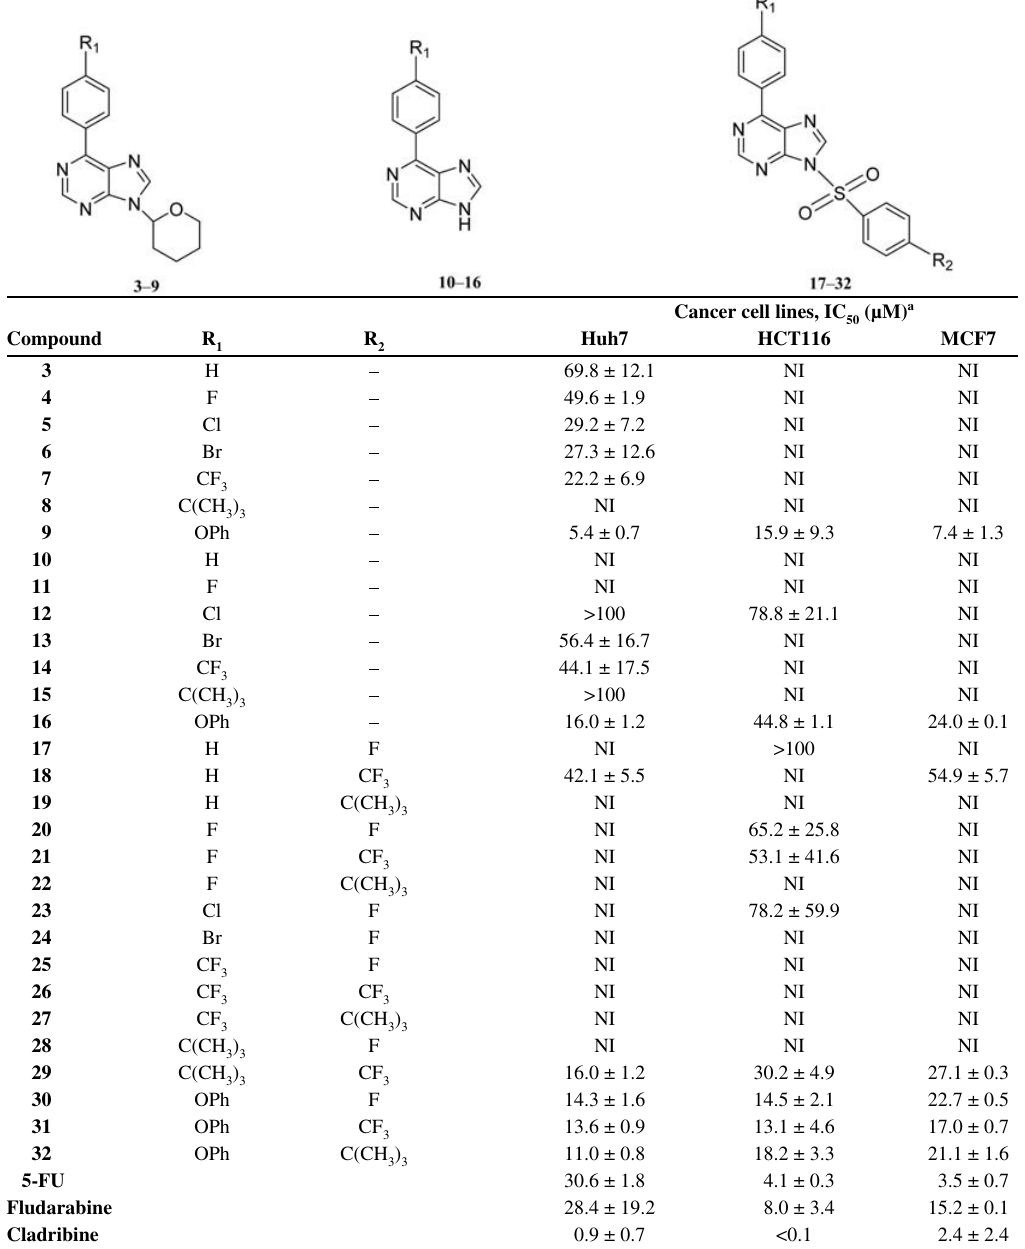
Table 1. In vitro cytotoxicity of the compounds 3 – 32 on different human cancer cell lines (Huh7, HCT116,